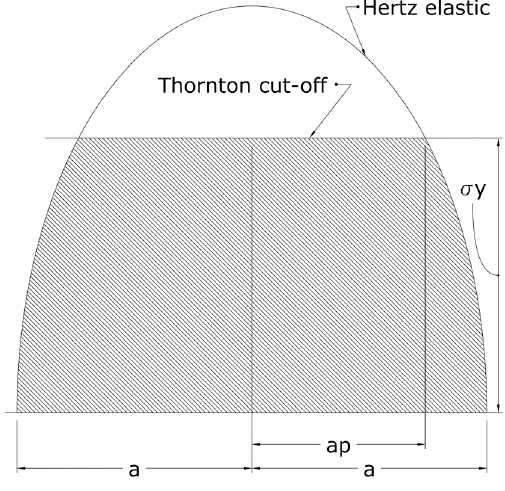
Figure 3. The Thornton cutoff at yielding stress.